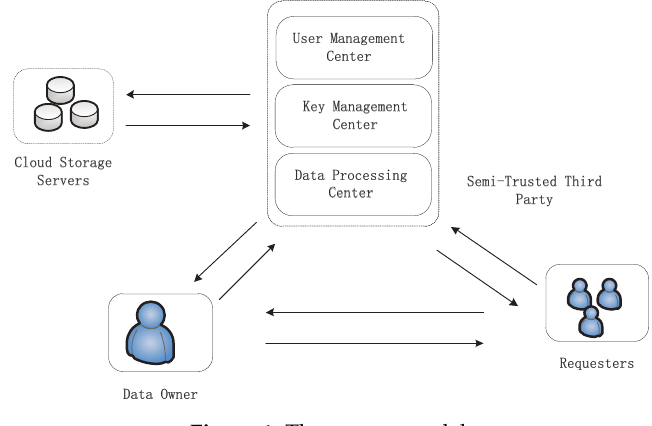
Figure 1. The system